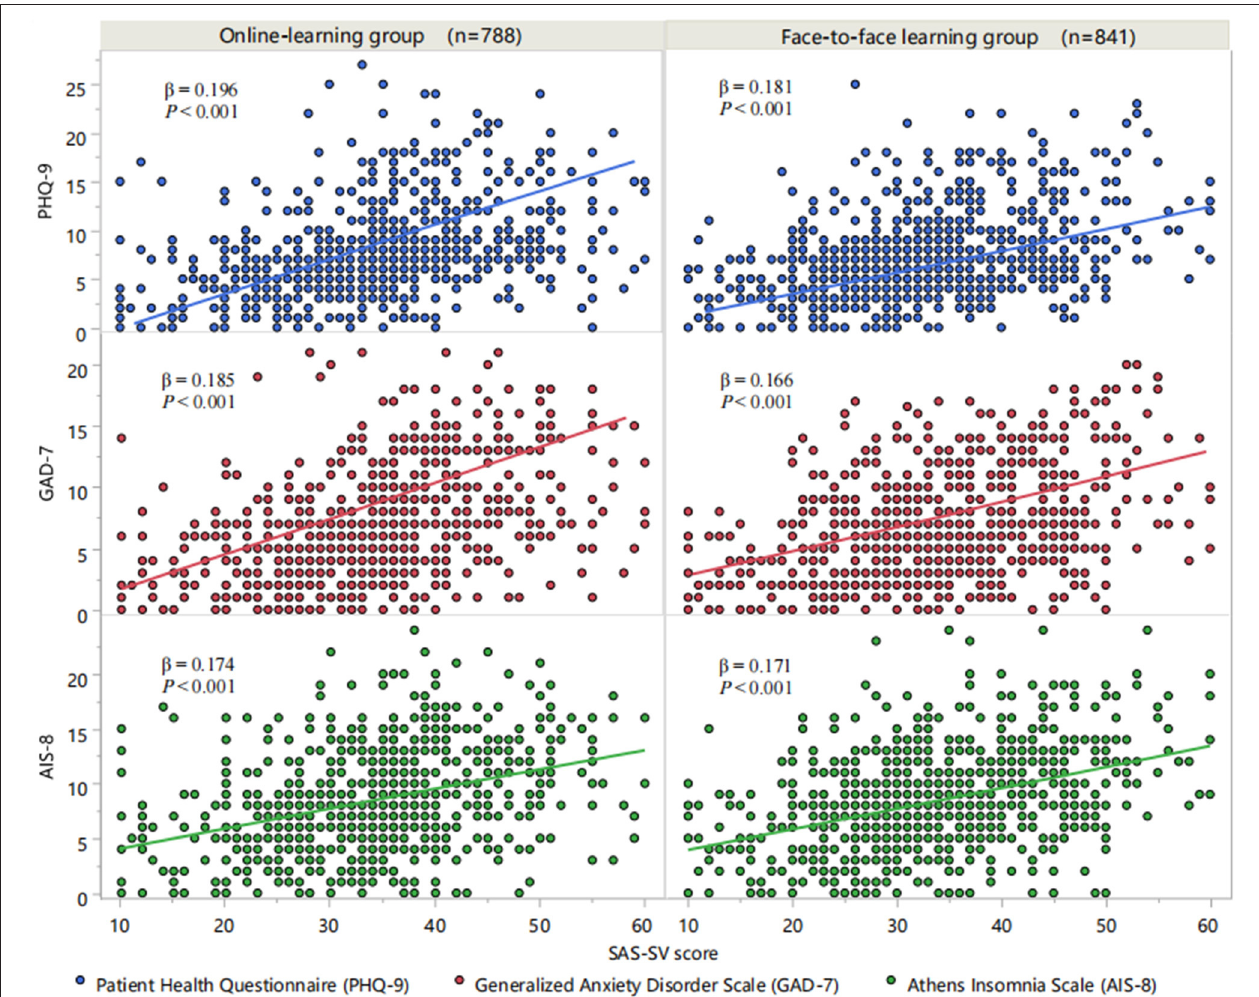
FIGURE 1 | Associations between SAS-SV and PHQ-9, GAD-7, and AIS-8 scores. SAS-SV, Smartphone Addiction Scale-Short Version; PHQ-9, 9-item Patient Health Questionnaire; GAD-7, 7-item Generalized Anxiety Disorder Scale; AIS-8, 8-item Athens Insomnia Scale.